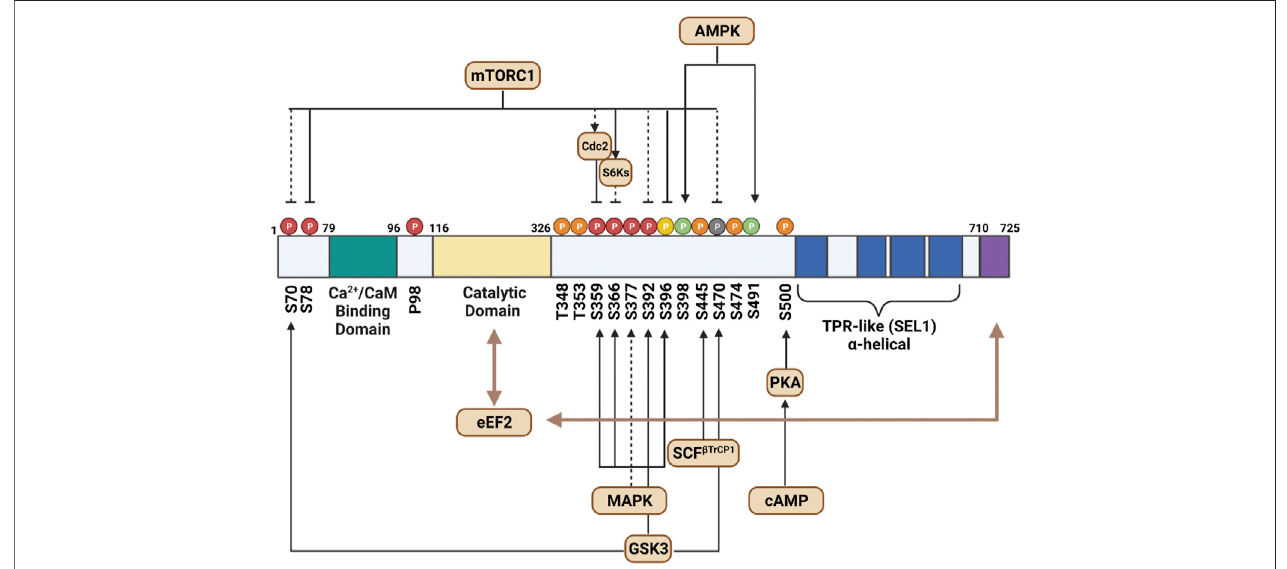
FIGURE 1 | This schematic outlines the structure of eEF2K and the primary functional features of the molecule. It additionally depicts the direct (solid lines) and indirect (dashed lines) signaling pathways that moderate its activity. The end of the C-terminal, shown in purple, assists the catalytic domain, characterized in yellow, to phosphorylate eEF2. The phosphorylated residues shown in green indicate sites that activate eEF2K activity, and residues in red depict inhibited eEF2K sites. The auto- phosphorylated residues that trigger eEF2K are shown in orange. Sites shown in yellow represent residues that indirectly affect the phosphorylated sites near N-terminus, and gray residues are those that have known phosphorylation activity but do not affect eEF2K